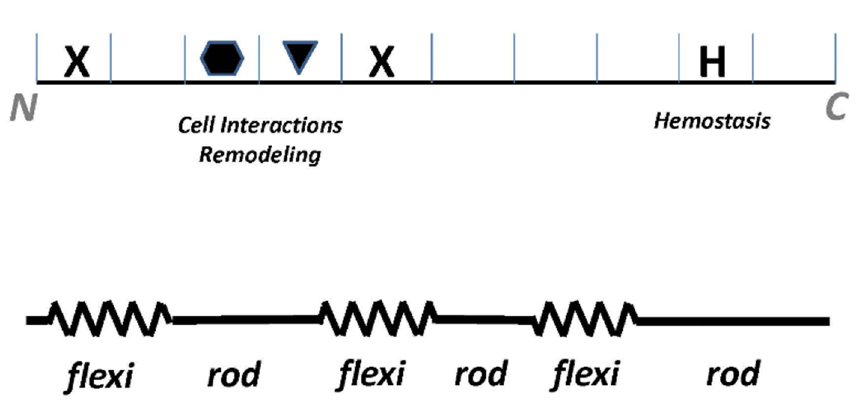
Figure 6. Analysis of type III collagen interactome suggests a “flexi-rod” model of fibril structure. Top: schematic of type III collagen fibril with sites for cell interactions and remodeling is flanked by intermolecular crosslinks (X) and a hemostasis domain (H). Bottom: Clusters of atypical collagen sequences of lower stability (springs) are interspersed with rigid zones (rods) hosting crucial biologic functions. Reprinted with permission from [74].